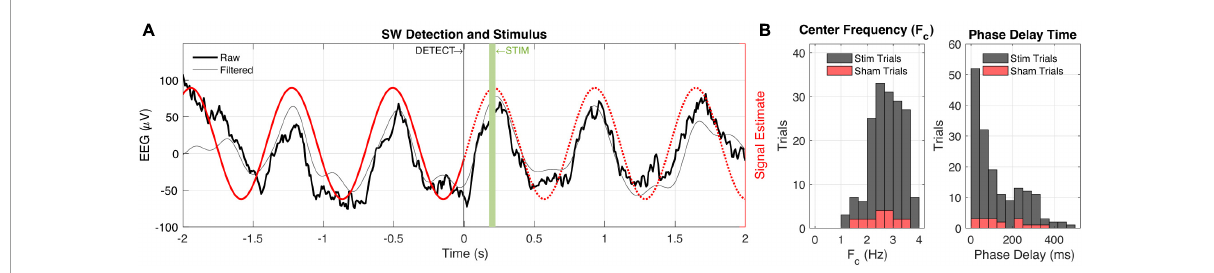
FIGURE4 Closed-loop slow-wave activity detection and audio stimulation. (A) Peri-detection EEG data are shown (black) with a 0.5–4 Hz bandpass filter applied to better visualize slow-wave (SW) activity. The signal estimate (red) is based on the center frequency and phase estimation of the biologger which is relayed to the base station at t = 0. The base station subsequently estimates a phase delay time to play 50 ms audio stimulus at the up-going phase of the ongoing SW activity. (B) Session-wide ( n = 202 trials) values for center frequency (Fc, left) and phase delay time (right). Sham trial distributions (10% probability) are shown in red.